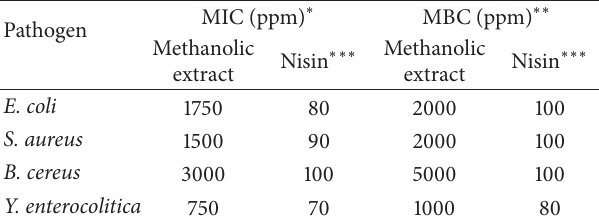
Figure 2: Antiplatelet aggregation activity of methanolic extract of stem of Plectranthus amboinicus at different concentrations. Values followed by different letters are significantly different ( 𝑃 < 0.05 ) from each other. Table 2: Minimum inhibitory concentration (MIC) and minimum bactericidal concentration (MBC) of the methanolic extract of stem against selected foodborne pathogens.